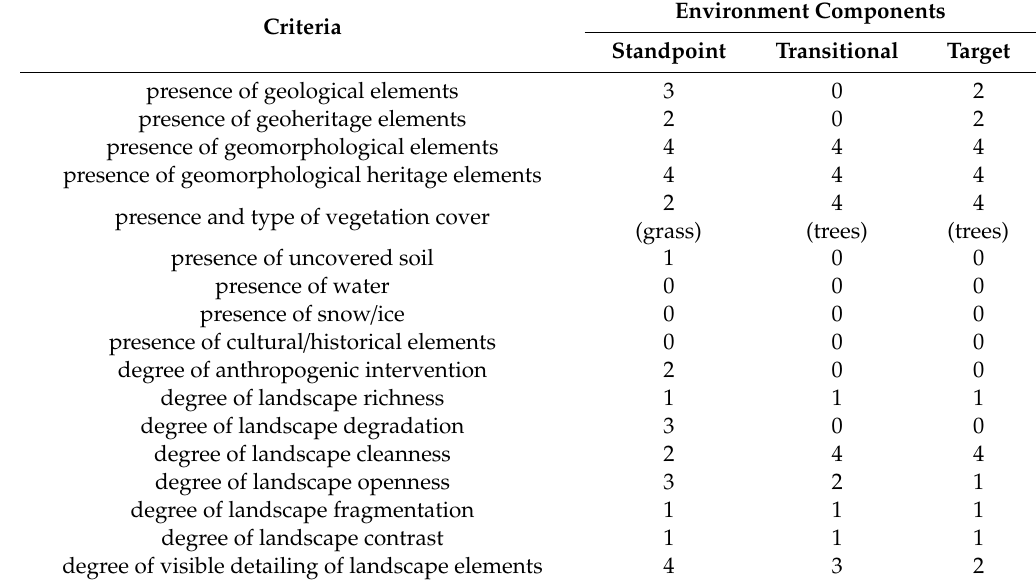
Table 1. Environment of the Mishoko Cli ff geosite / geomorphosite. Criteria